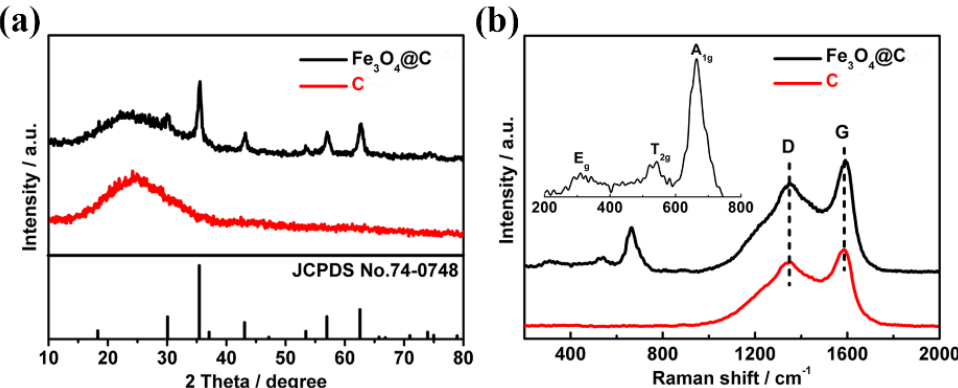
Figure 3. ( a ) XRD patterns of Fe 3 O 4 @C composite, RP-derived carbon; ( b ) Raman spectra of Fe 3 O 4 @C composite and RP-derived carbon. The inset shows the enlarged region at low Raman shift.